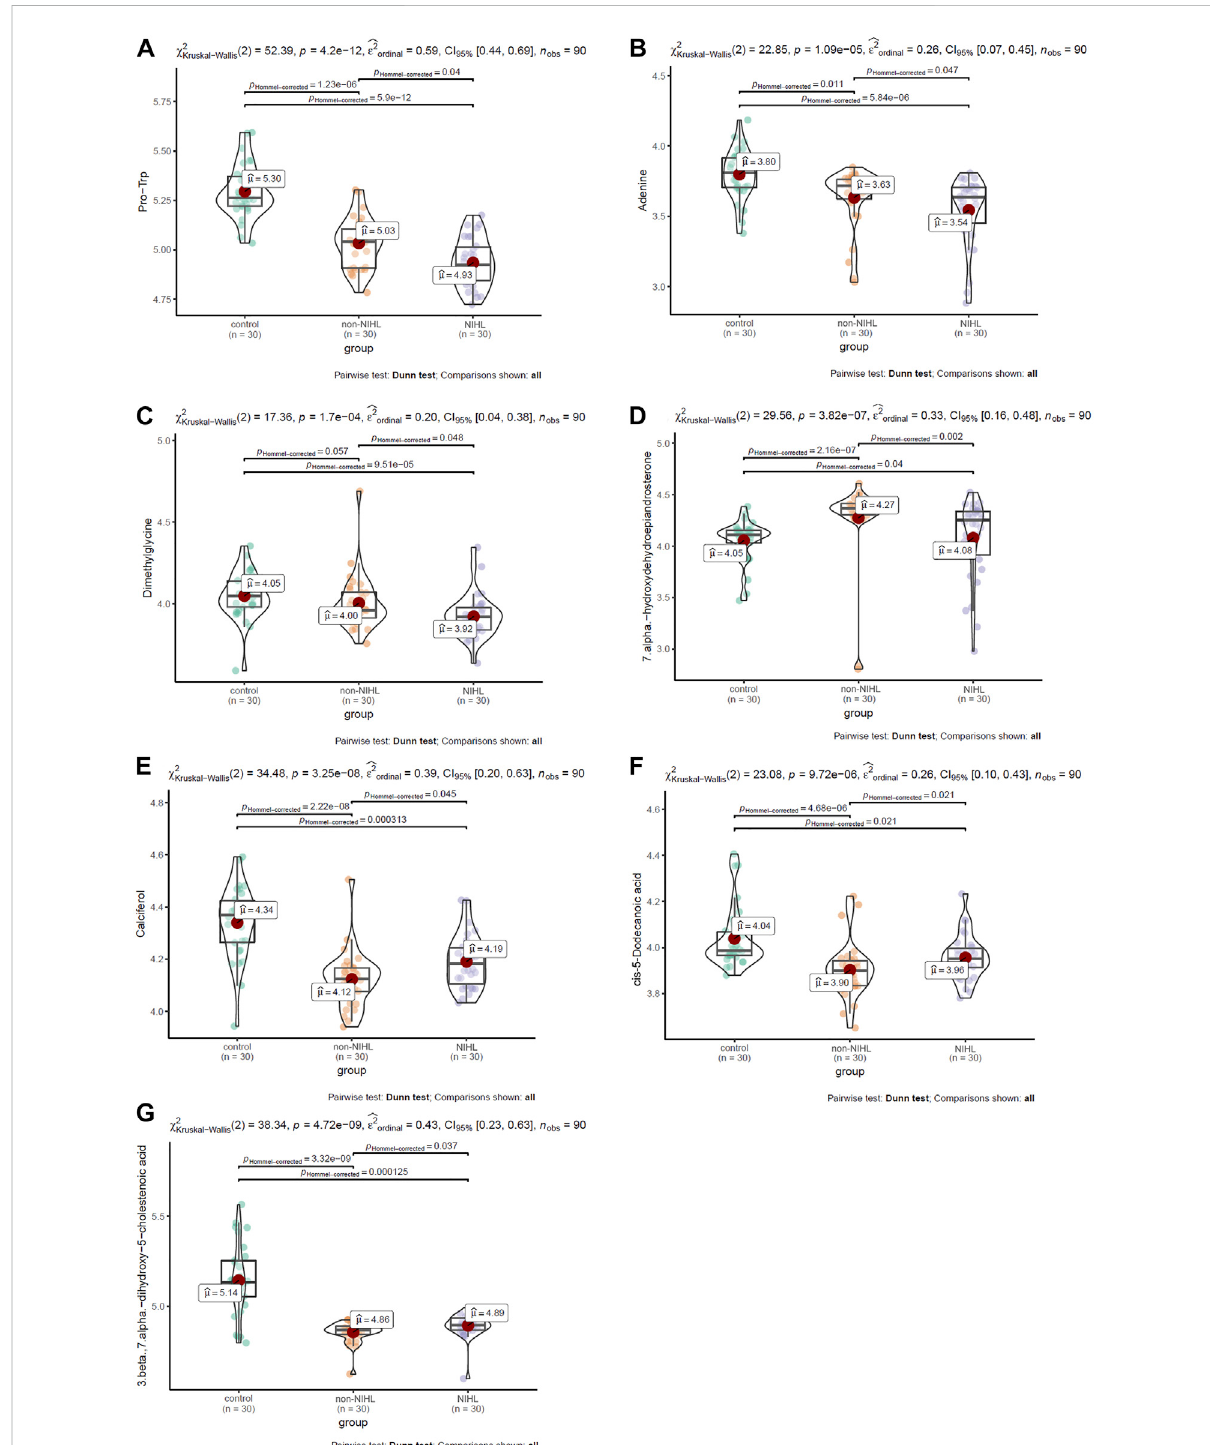
FIGURE 5 Multiple comparisons of DMs-NIHL between different groups. (A – G) Multiple comparisons of Pro-Trp, adenine, dimethylglycine, 7 alpha- hydroxydehydroepiandrosterone, calciferol, cis-5-dodecenoic acid, and 3 beta,7 alpha-dihydroxy-5-cholestenoic acid, respectively. DMs-NIHL, differential metabolites associated with noise-induced hearing loss. The Kruskal – Wallis test was used with the “ ggstatsplot ” package in R. Hommel- corrected p < 0.05 was considered statistically signi fi